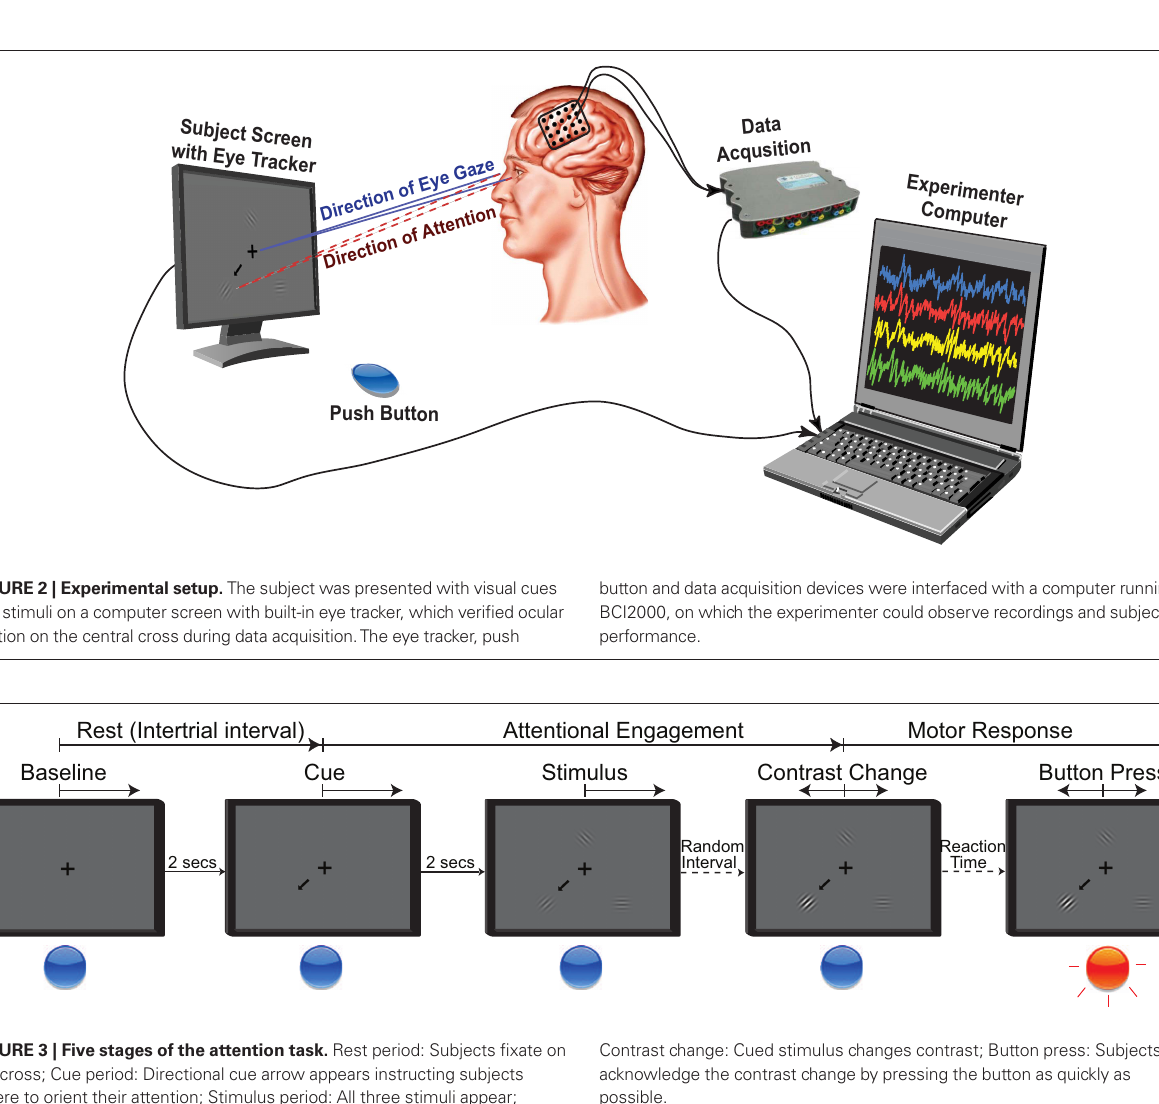
FIGure 3 | Five stages of the attention task. Rest period: Subjects fixate on the cross; Cue period: Directional cue arrow appears instructing subjects where to orient their attention; Stimulus period: All three stimuli appear;